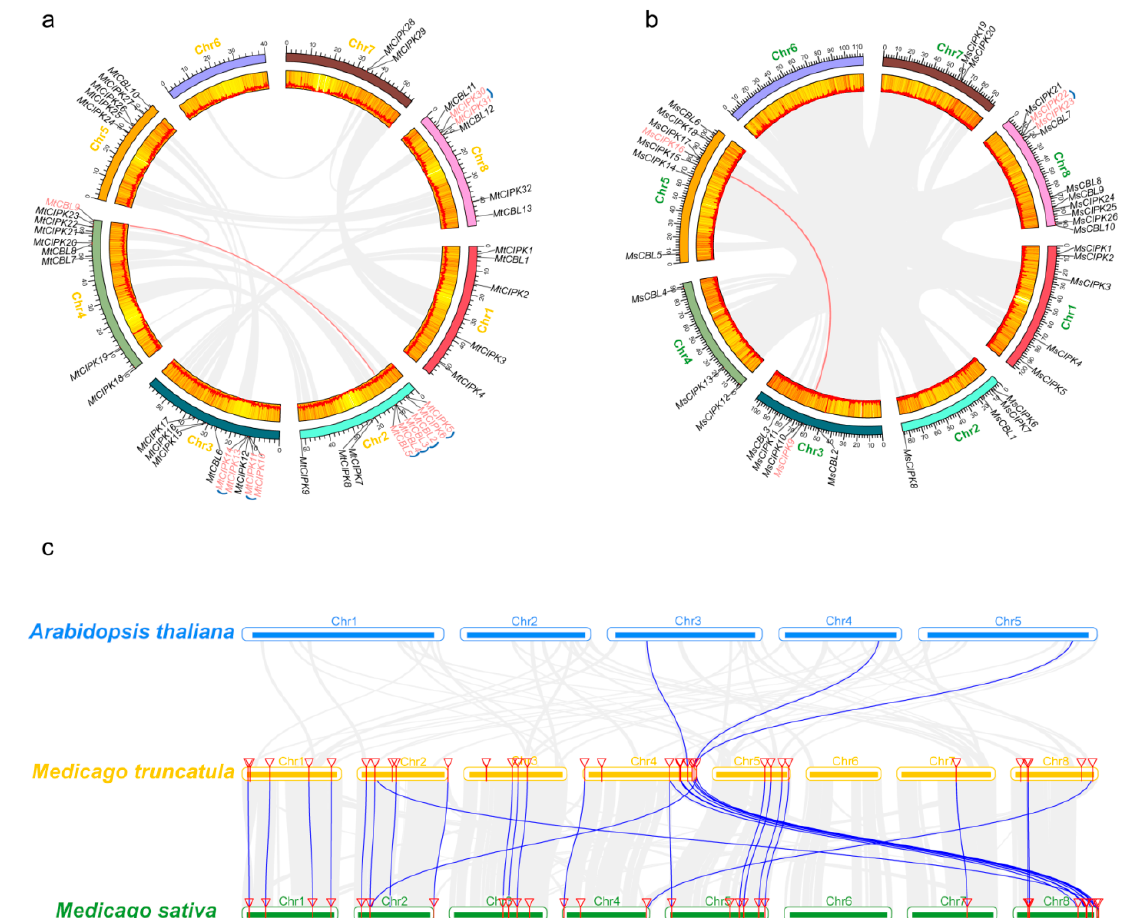
Figure 3. Chromosome distributions of CBLs and CIPKs in M. truncatula and M. sativa . The chromosomal location and interchromosomal relationships of CBL and CIPK genes. The tandem duplicated genes are marked by blue arc trajectory and segmentally duplicated genes are connected by red curves. The chromosomal location and interchromosomal relationships of M. truncatula ( a ) and M. sativa ( b ). ( c ) Synteny analysis of CBL and CIPK genes between M. sativa , M. truncatula and representative plant species ( Arabidopsis ). Gray lines in the background indicate the collinear blocks within M. truncatula , and M. sativa / Arabidopsis , and the blue lines highlight the syntenic CBL and CIPK gene pairs.